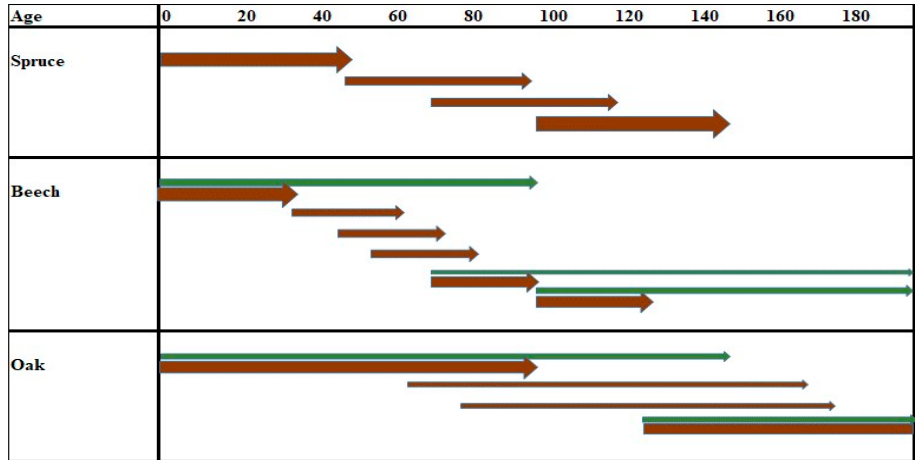
Figure 4. Simplified visualization of dendromass enrichment phases (green color) and necromass (brown color) according to tree species.